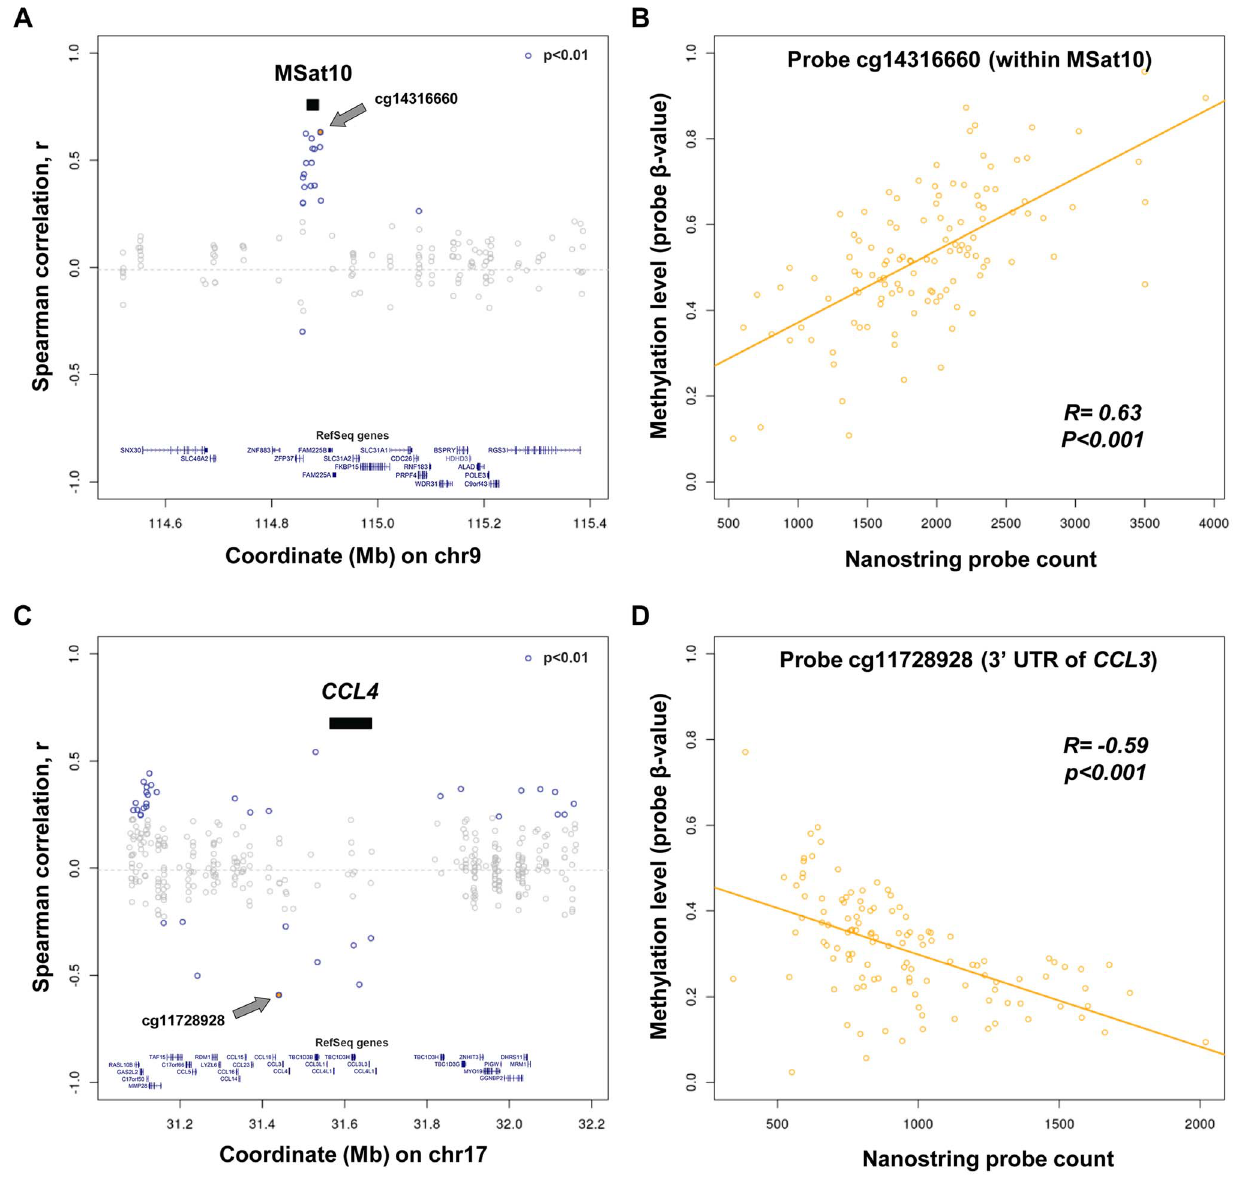
Figure 4. Variation in copy number of tandem repeats and multicopy genes is associated with alterations of local DNA methylation. (a and c) Shown are correlation values between copy number of (a) MSat10 and (c) CCL4 with all methylation probes within 6 500 kb in 118 CEU and YRI HapMap individuals. (b and d) Scatter plots showing individual level data for the methylation probes showing the strongest correlations with copy number of Msat10 and CCL4 . (b) Increasing copy number of MSat10 is associated with increased methylation levels of cg14316660, (R=0.63, permutation p , 0.001). This association was replicated using a Sequenom assay targeted to the MSat10 locus (Figure 5c), confirming that it is not simply due to a technical artifact related to CNV of the underlying probe binding sites. (d) Increasing copy number of CCL4 is associated with reduced methylation levels of cg11728928 (R= 2 0.59, permutation p , 0.001). In (a) and (c), black bars indicate the interval to which each Nanostring probe maps, CpGs showing correlation p , 0.01 are indicated in blue, while the CpG showing the strongest correlation is shown as a filled blue circle and labeled with a grey arrow (with individual data plotted in (b) and (d), respectively). variable DNA methylation at MSat10 that showed a strong positive correlation with repeat copy number (R 2 =0.76, p=4.4 6 10 2 12 , Figure 5c). Chip-seq analysis also showed high levels of repressive